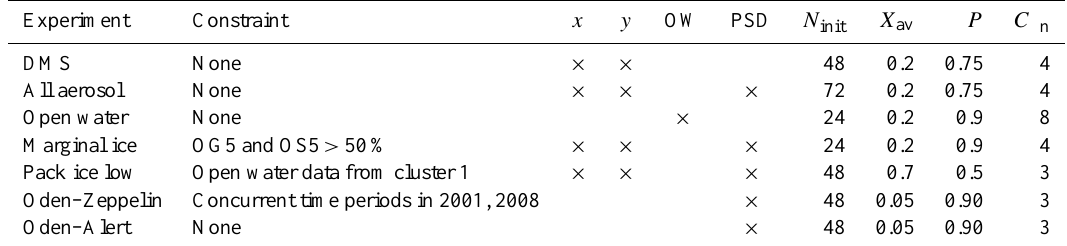
Table 2. Run parameters of the cluster experiments. Constraint stands for constraints on data input to clustering algorithm. OW means percentage of open water along the trajectories. PSD means particle size distribution. N init means initial number of hours required in each cluster. X av means average distance of the cluster members from a cluster average of normalized coordinates (see Eq. 1). P ( P ≤ 1) means outlier reduction factor to be applied to each cluster (see Sect. 3). C fin means number of clusters after eliminating clusters with smallest average distance from any other cluster (see Sect.